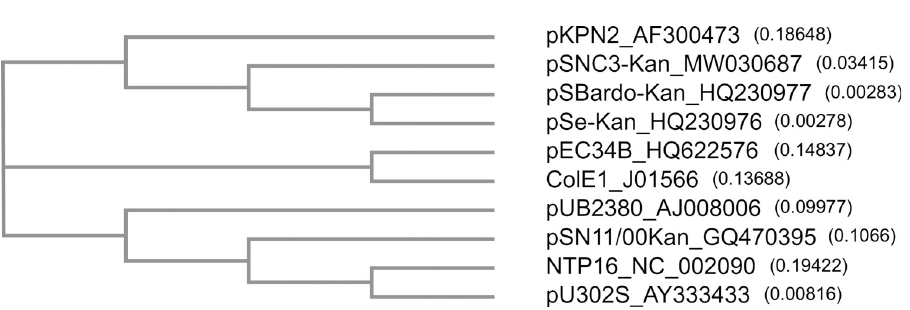
Fig 4. Cladogram of KanR plasmids and other plasmids. Neighbor-joining tree (without distance corrections) generated from multiple sequence alignment using MUSCLE. Plasmid name is followed by GenBank accession number (nucleotide sequence); branch length is indicated within the parentheses. Relevant information on the plasmids used in the alignment is listed in the S1 Table.